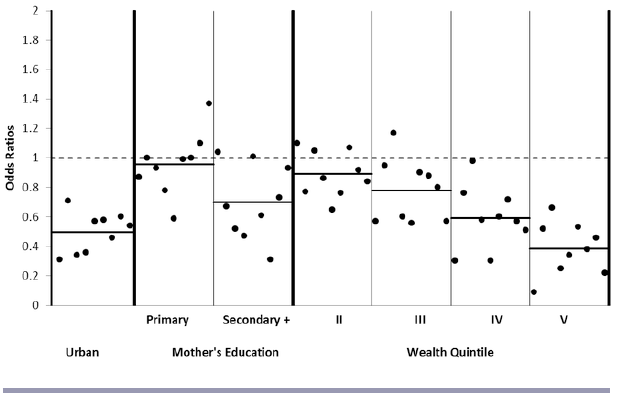
Fig. 2 . Country-specific and mean odds ratios for malaria parasitemia in children for urban residence, maternal education category, and wealth quintile from country-specific reduced (IA) hierarchical logistic regression